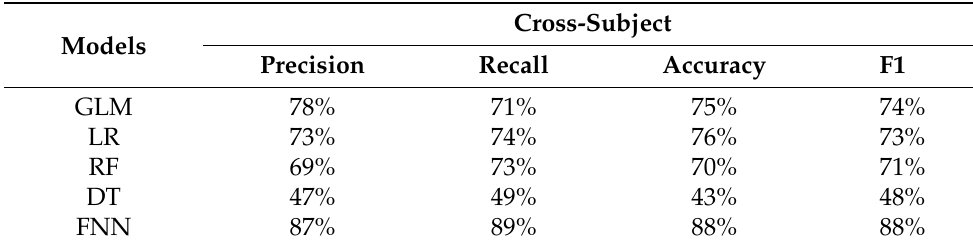
Table 7. Average precision, recall, and accuracy for cross-subject validations using the 16 extracted features to detect fatigue in biceps